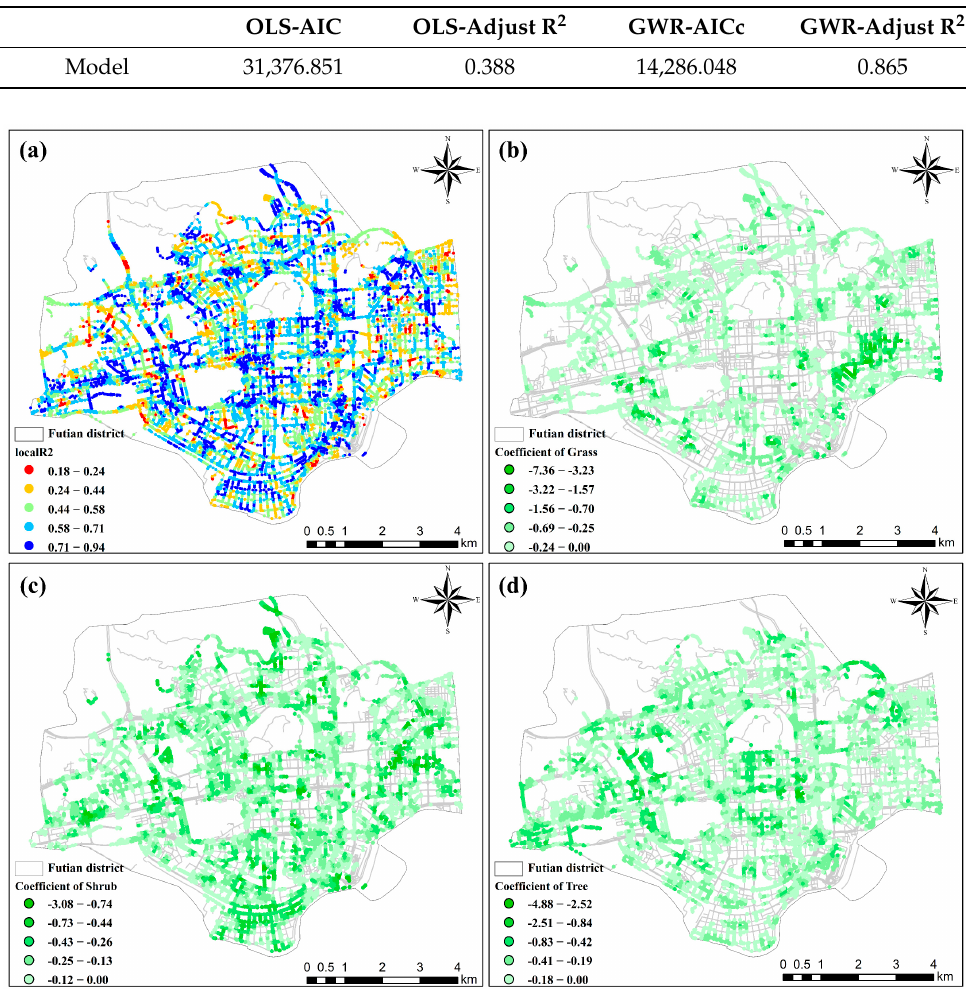
Table 3. Comparison between GWR and OLS results.